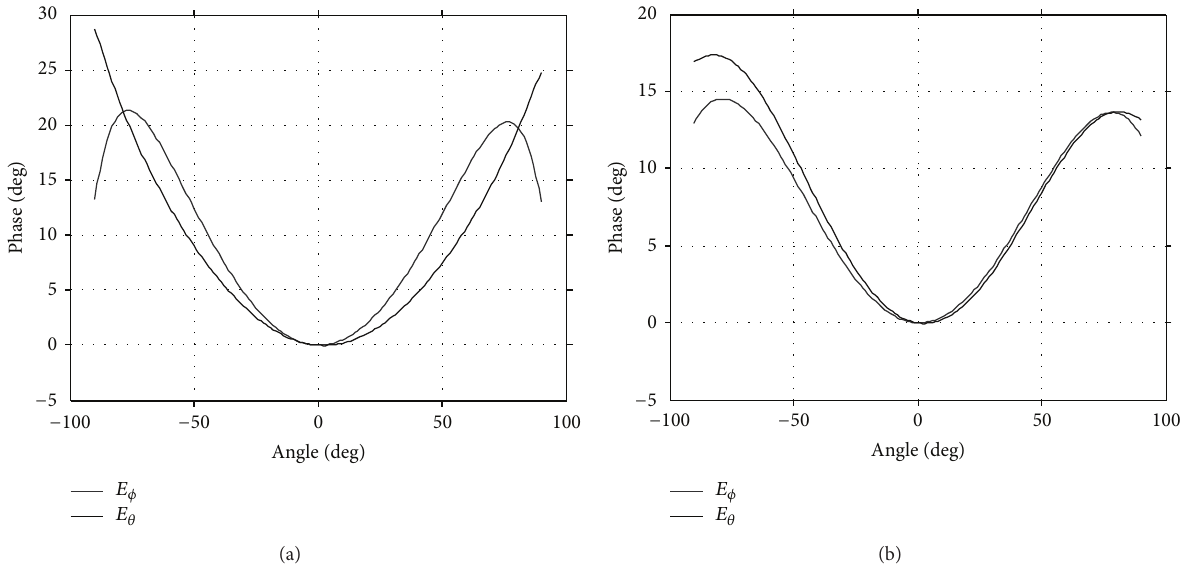
Figure 10: (a) Phase radiation pattern of circular waveguide at 𝑟 = 𝐷 2 /𝜆 . (b) Phase radiation pattern of circular waveguide at 𝑟 = 2𝐷 2 /𝜆